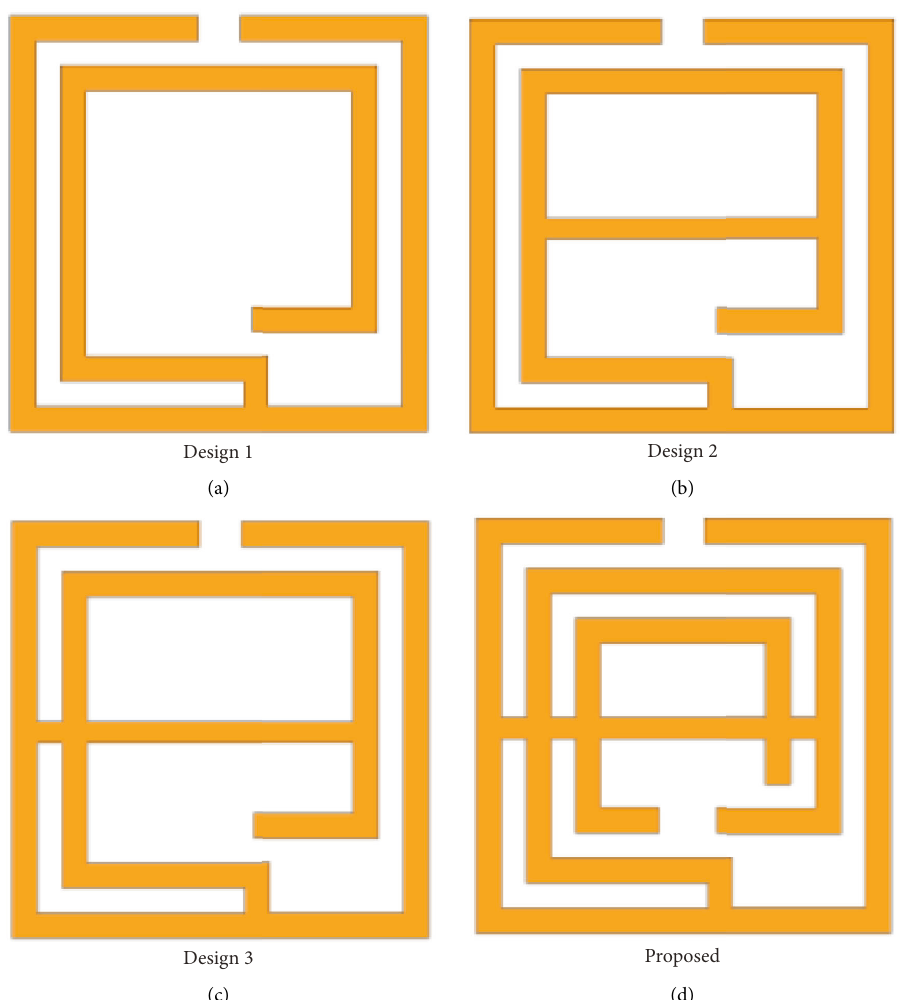
Figure 2: Different design stages of MTM unit cell structure. (a) Design 1 (b) design 2 (c) design 3 (d) proposed.